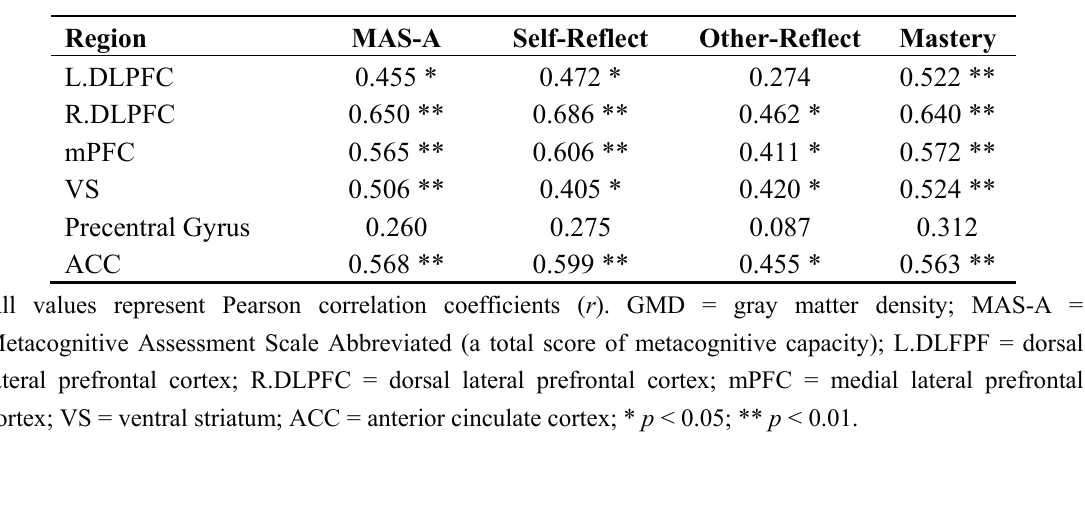
Table 3. Correlational analysis of gray matter density (GMD) in significant clusters and